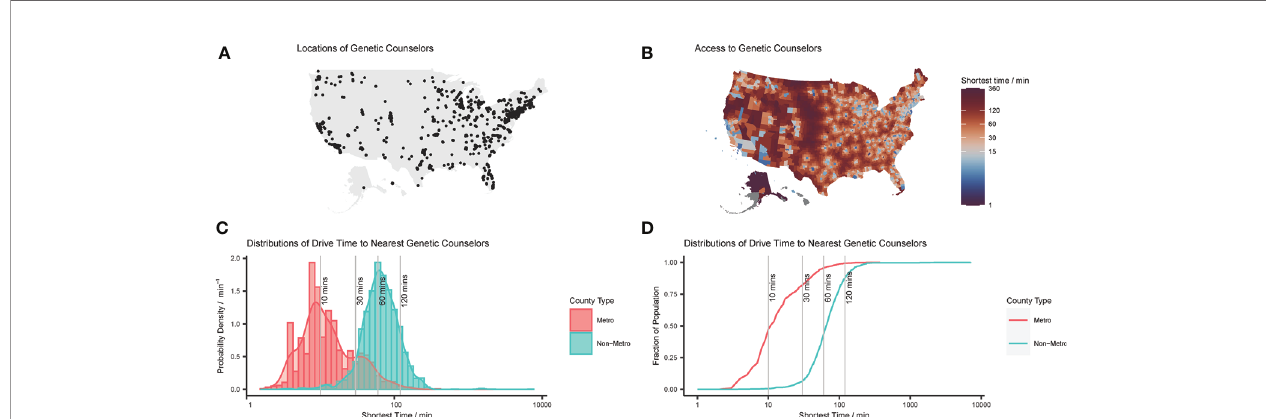
FIGURE 1 | Distributions of genetic counselors in the United States: (A) point locations of genetic counselors reconciled from disparate data sources; (B) mapped distribution of county-level drive-time to closest genetic counselor; (C) histogram and probability density function of county-level drive-time to nearest genetic counselor; and (D) cumulative density function of county-level drive-time to nearest genetic counselor. Note that in (C, D) the shortest drive-times to a genetic counselor are plotted on log axes, and that these values are population-weighted to take into account relative county